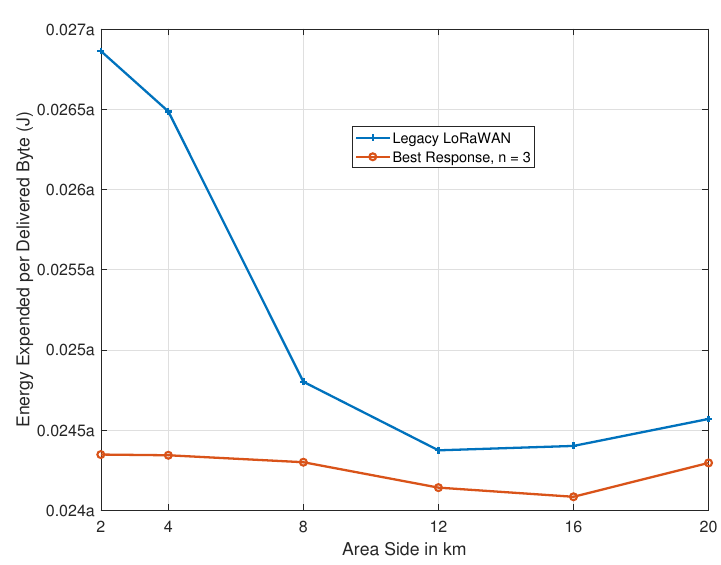
Figure 8. Energy expended per byte as a function of S .